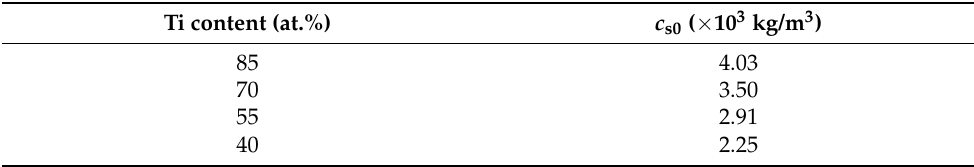
Table 6. The concentration of Ti atoms in the designed coating. Ti content (at.%)